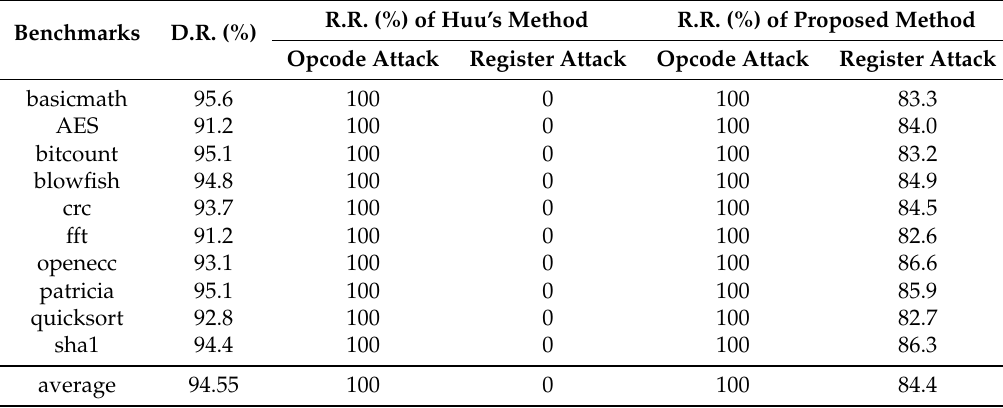
Table 1. Recovery rating comparison between Huu’s method and the proposal. Benchmarks